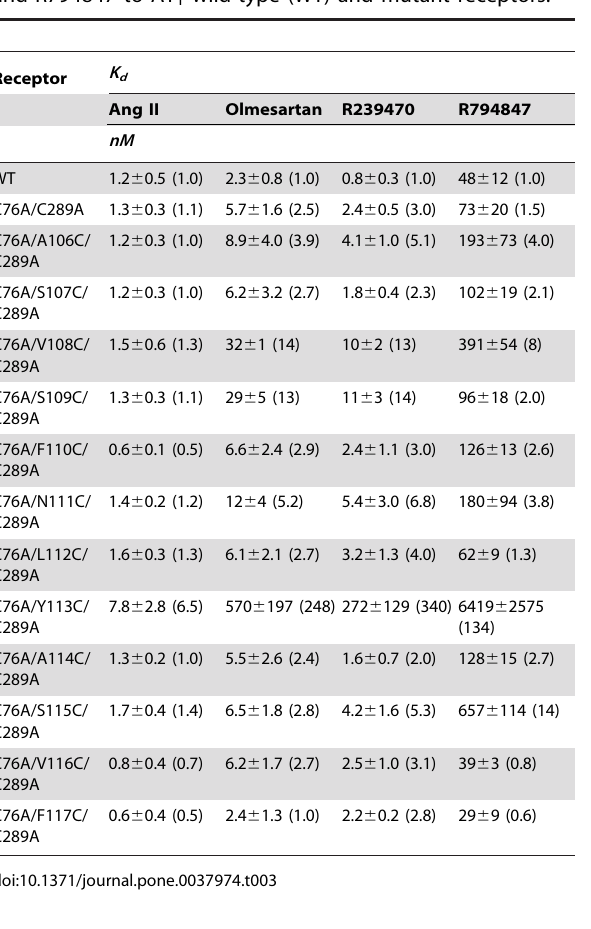
Table 3. Binding affinities ( K d ) of Ang II, olmesartan, R239470 and R794847 to AT 1 wild-type (WT) and mutant receptors.